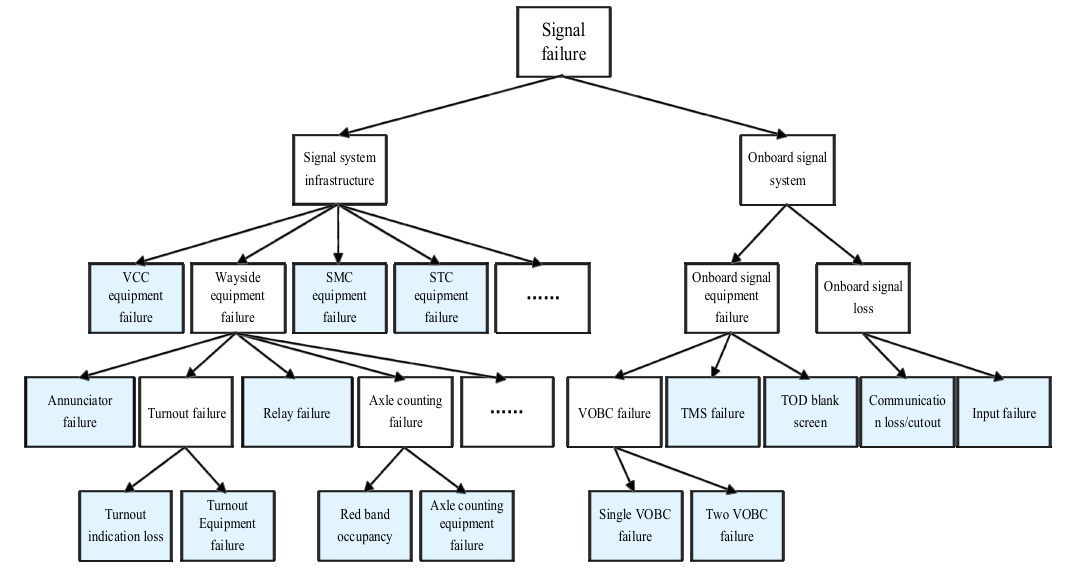
Figure 5. Semantic concept tree of signal failure.